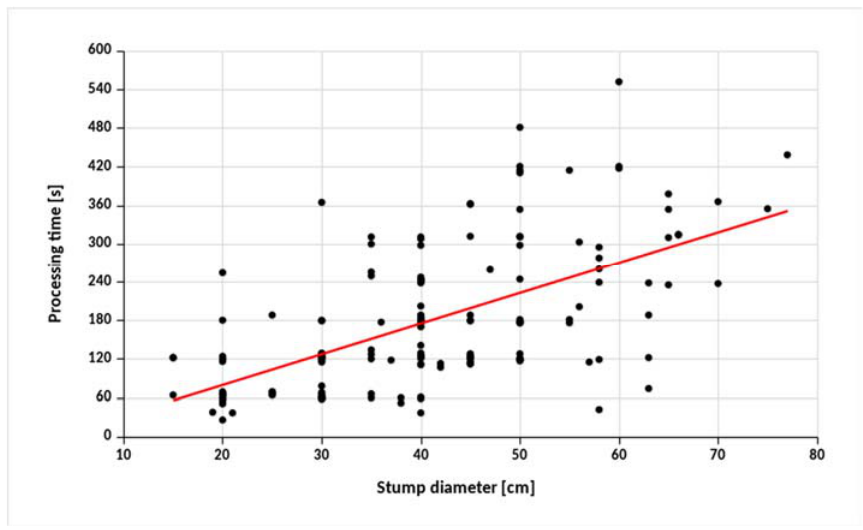
Figure 4. Statistical evaluation of time for processing one stump on the site of LZ Boubín, district of Netolice.